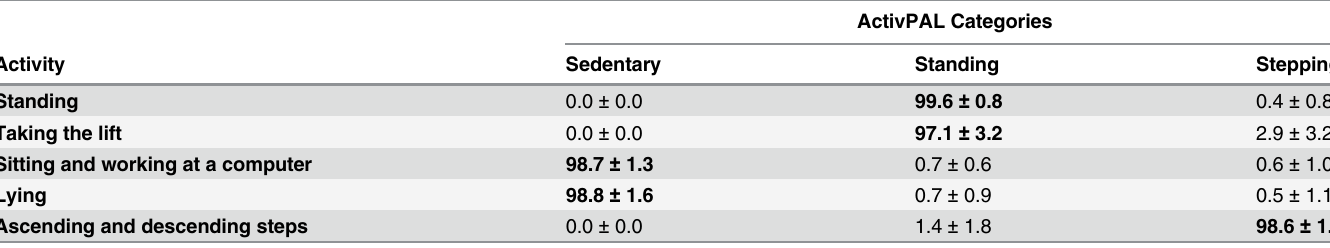
Table 5. Classi fi cation of the performed activities for the ActivPAL sensor.